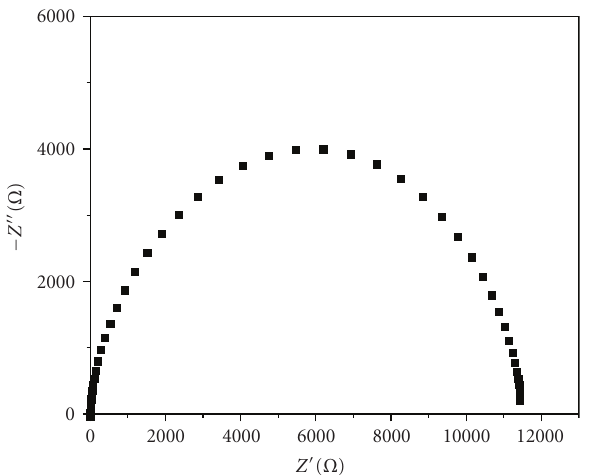
Figure 6: Nyquist diagram obtained at 300 ◦ C for SBTi film deposited by the soft chemical method and annealed at 700 ◦ C for 2 hours.